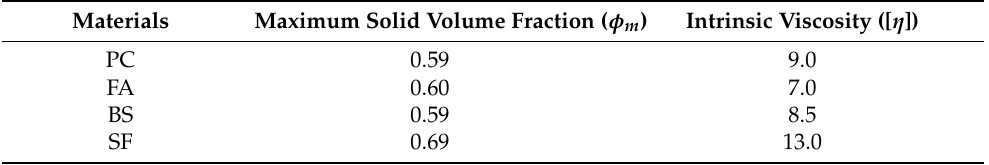
Table 7. Maximum solid volume fraction ( φ m ) and intrinsic viscosity ( [ η ] ).